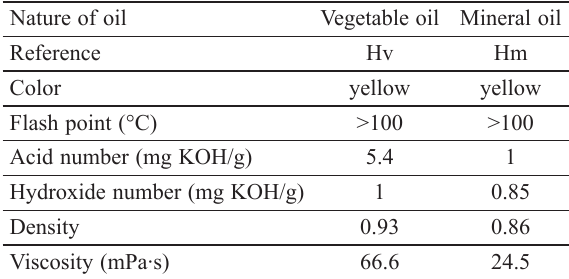
Table 3. Characteristics of the release agents